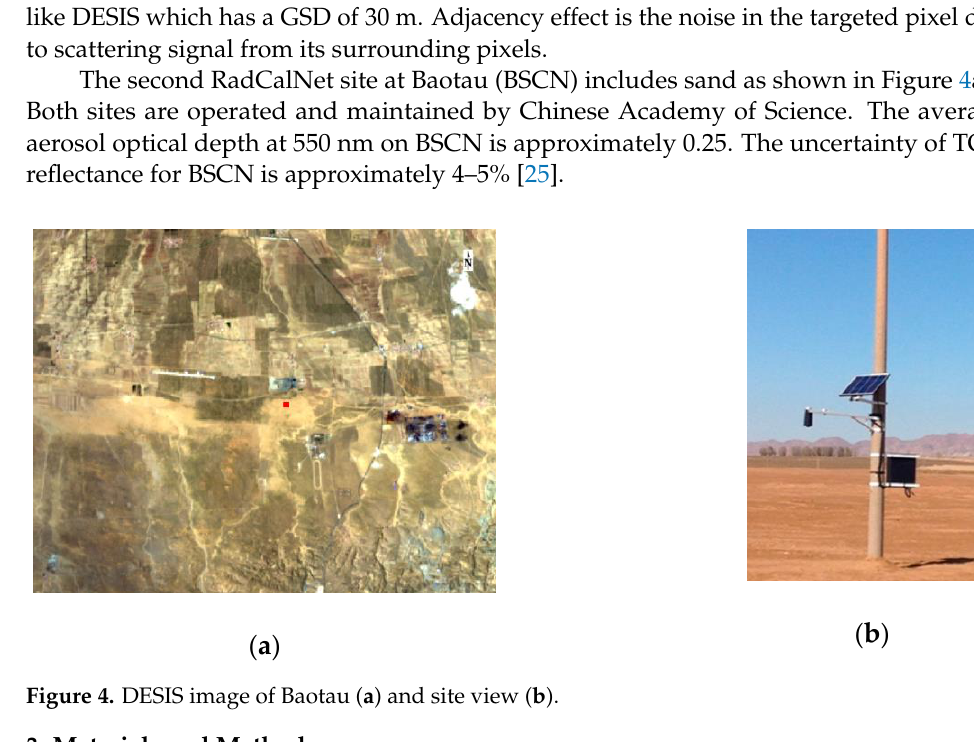
( b ) Figure 3. DESIS image of La Crau ( a ) and site view ( b ). 2.2.4. Baotau Sand